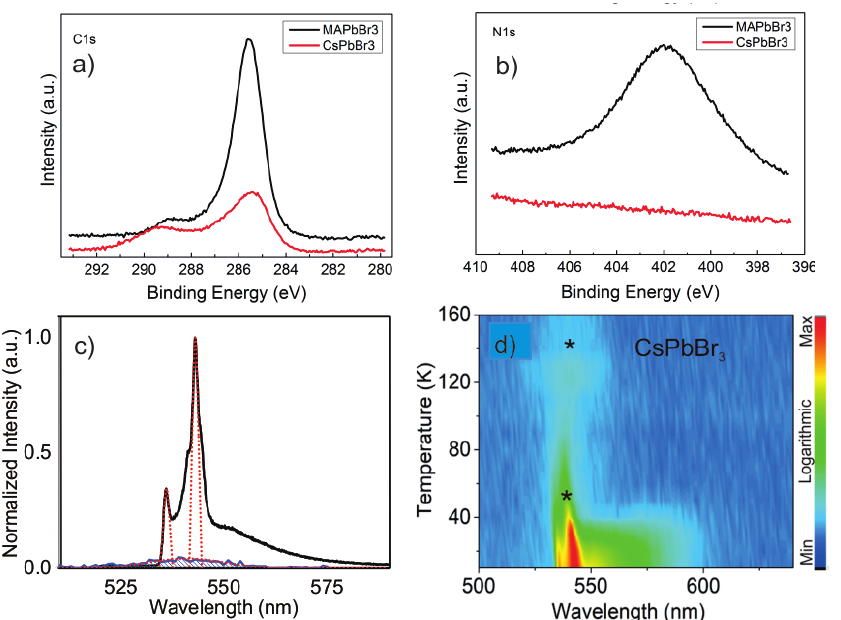
Figure 6. All inorganic scintillator, CsPbBr 3 . ( a , b ) X-ray photoemission spectra of the C1s and N1s core levels of MAPbBr 3 and CsPbBr 3 crystals. ( c ) Low- (10 K) and high-temperature (150 K) X-ray-excited luminescence spectra shown by white and blue-shaded area, respectively. ( d ) Temperature mapping of XL spectra from 10 to 160 K. Figures reproduced from ( c , d ) Aozhen, X. et al., J. Phys. Chem. C 2018 , 122, 16265–16273. 2018 by